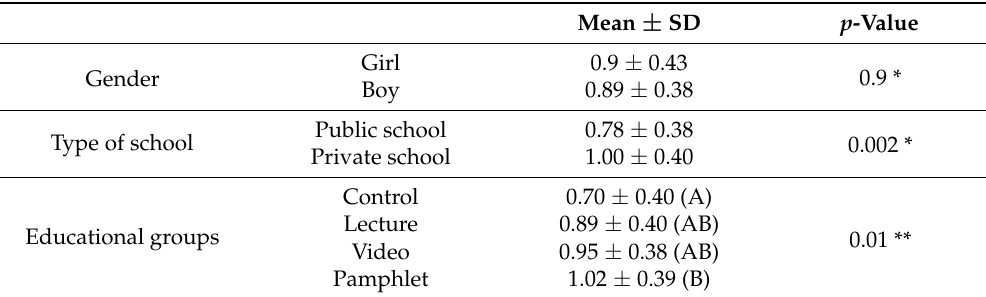
Table 1. The mean ( ± standard deviation (SD)) plaque index (PI) in baseline by gender, type of school and interaction groups.